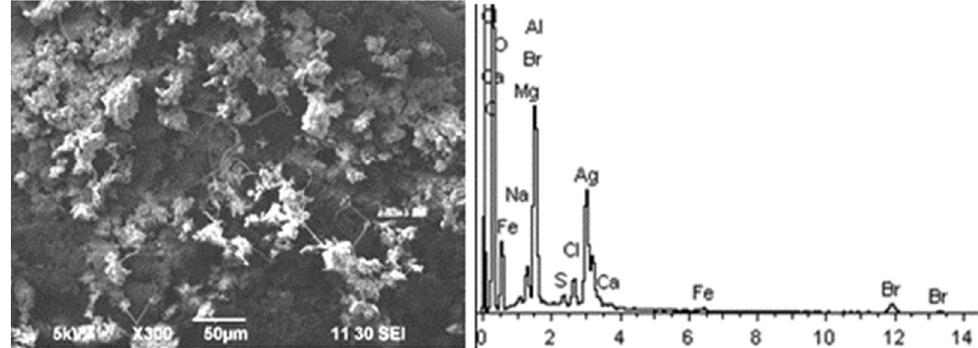
Figure 5. Aluminum etching. Particles morphology. Scanning electronic microscopy. Magnification